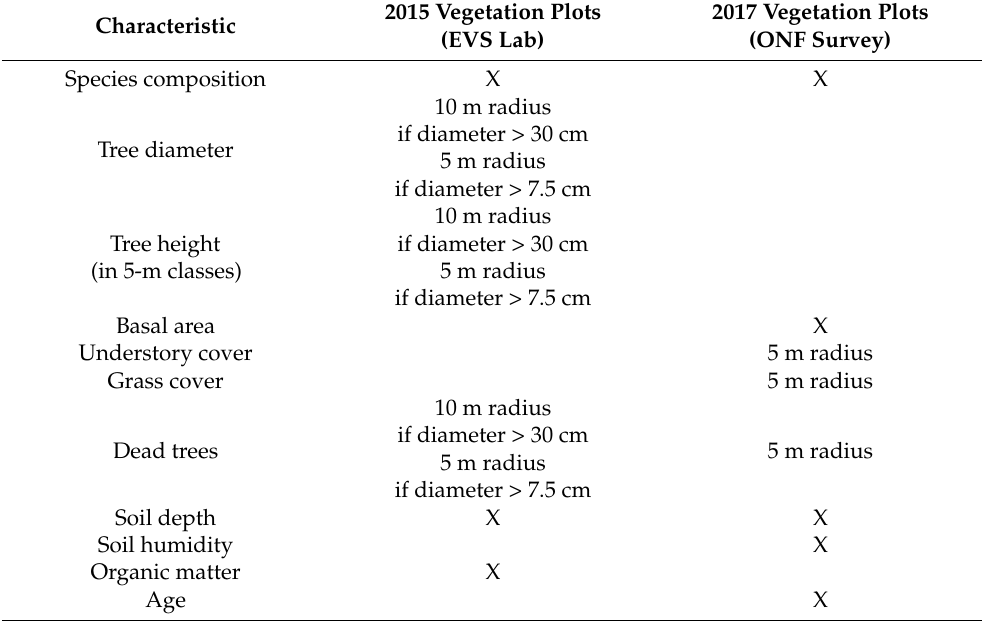
Table 3. Measurements and observations recorded in the two forestry surveys.